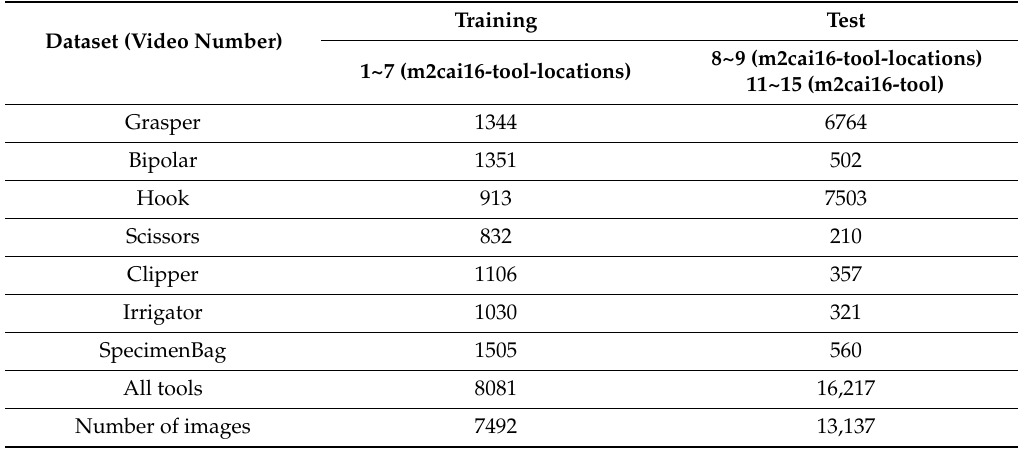
Figure 3. Image augmentation with flip. ( a ) original image, ( b ) horizontal flip, ( c ) vertical flip, ( d ) horizontal and vertical flip. Table 1. Number of classes and images in training and test datasets.